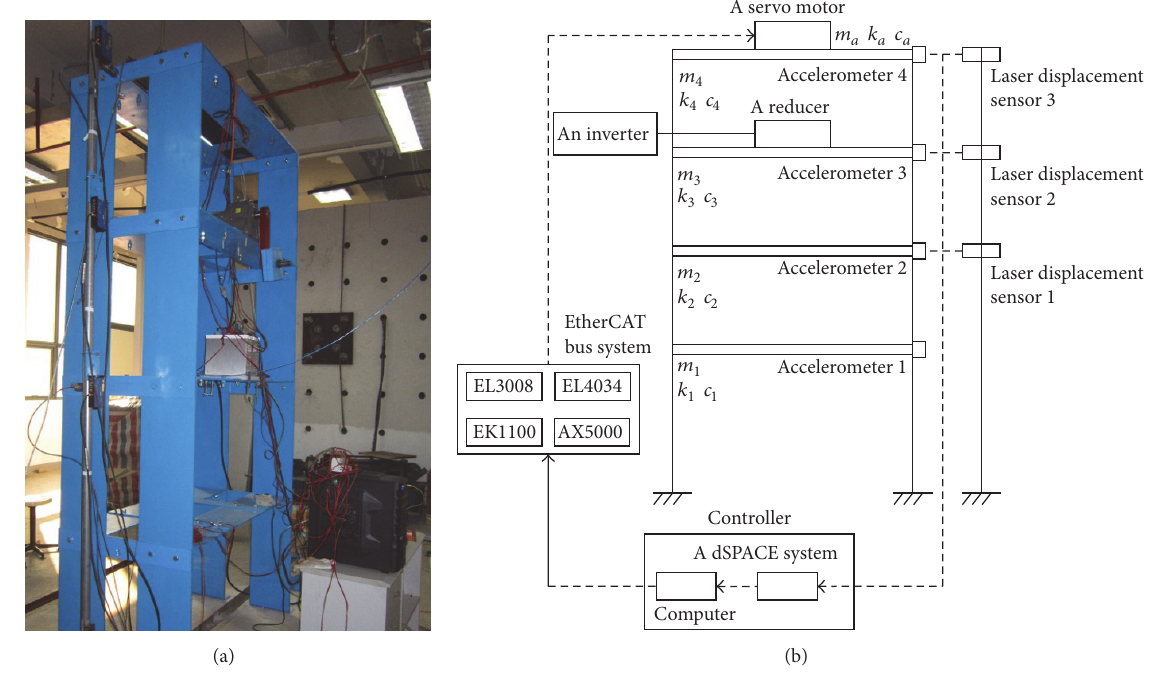
Figure 7: Pictures of the steel frame structure. (a) Practicality. (b)